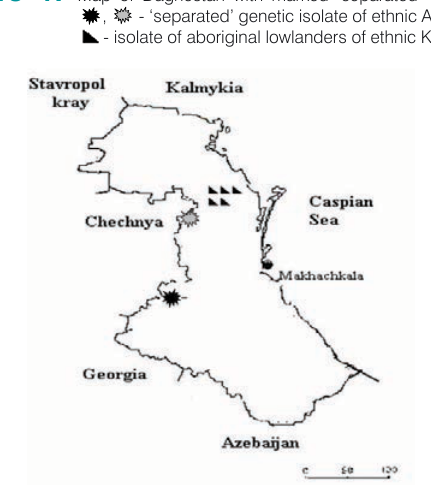
Figure 1. Map of Daghestan with marked ‘separated’ isolates: , - ‘separated’ genetic isolate of ethnic Avars; - isolate of aboriginal lowlanders of ethnic